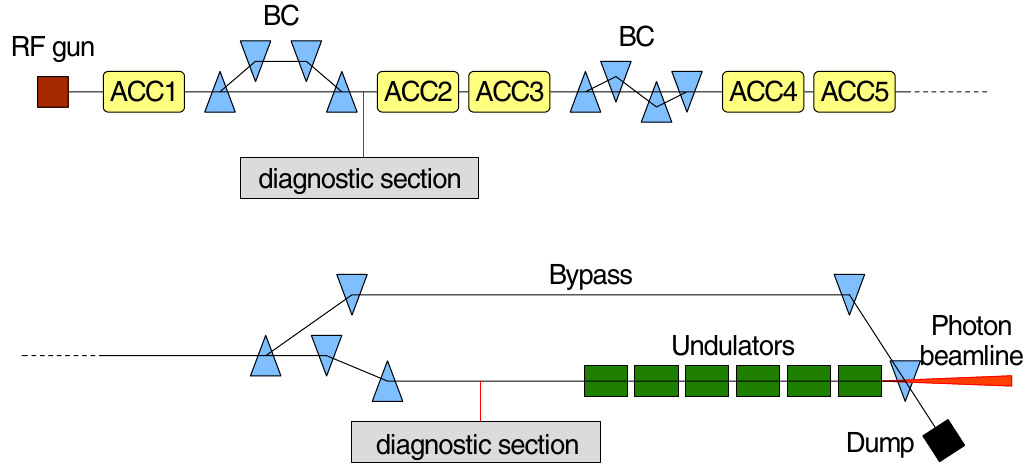
FIG. 1. (Color) Present layout of the linac (not to scale). Beam direction is from left to right. The electron bunches are accelerated in the superconducting structures ACC1–ACC5 and compressed longitudinally in two magnetic chicane bunch compressors. The total length is about 250 m. The emittance measurements discussed in this paper are performed in the diagnostic section after the first bunch